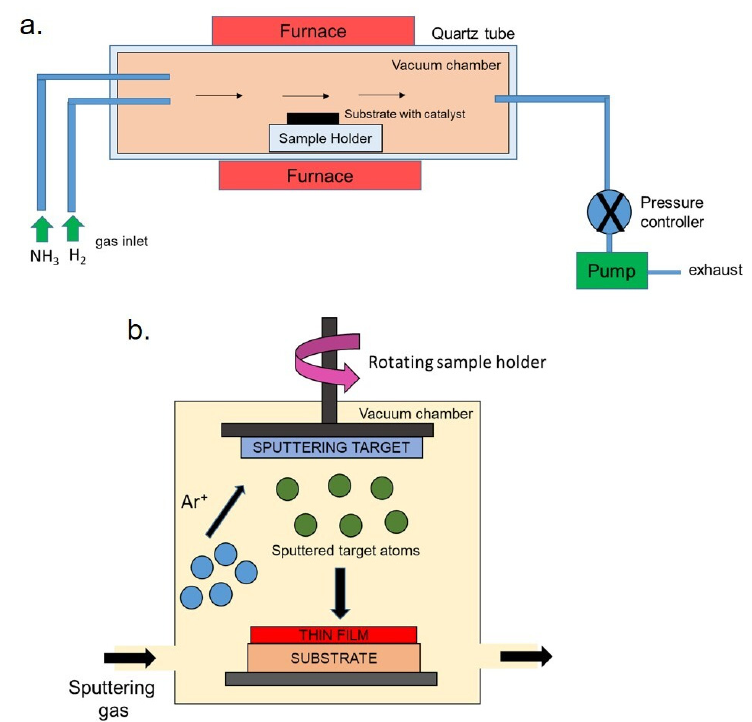
Figure 2. ( a ) Schematic representation of Chemical Vapor Deposition (CVD) and ( b ) Physical Vapor Deposition (PVD) processes.